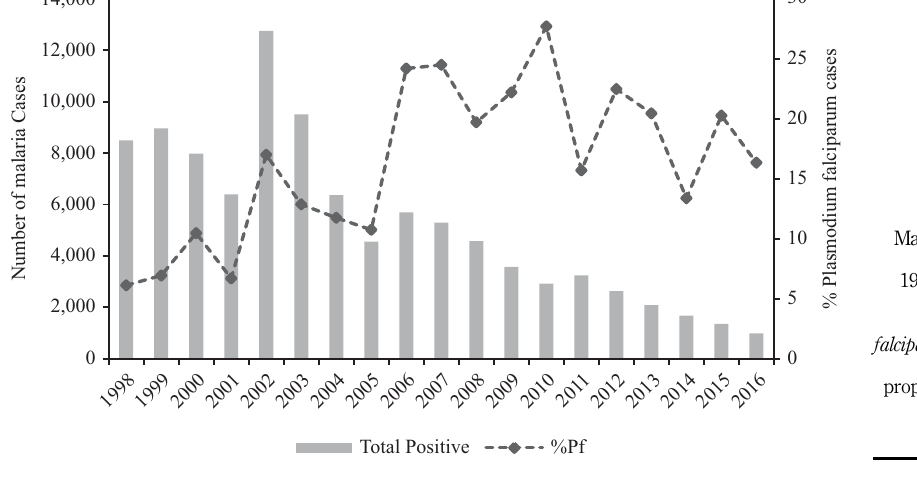
Figure 1. Malaria incidence in Nepal during 1998 – 2016 with the proportion of Plasmodium falciparum , Pf (%) and the remaining proportion represents the proportion of Pv